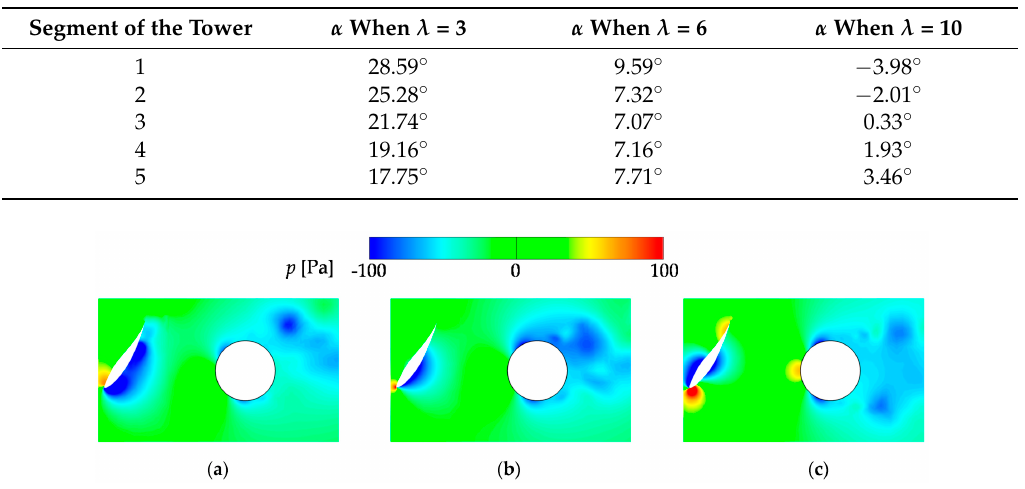
Figure 9. Horizontal distributions of the static pressure at the mid-height of segment 1 when the blade is located at Ψ = 0°. ( a ) λ = 3, t = 2.793032 (s); ( b ) λ = 6, t = 2.800312 (s); and ( c ) λ = 10, t = 2.794554 (s).